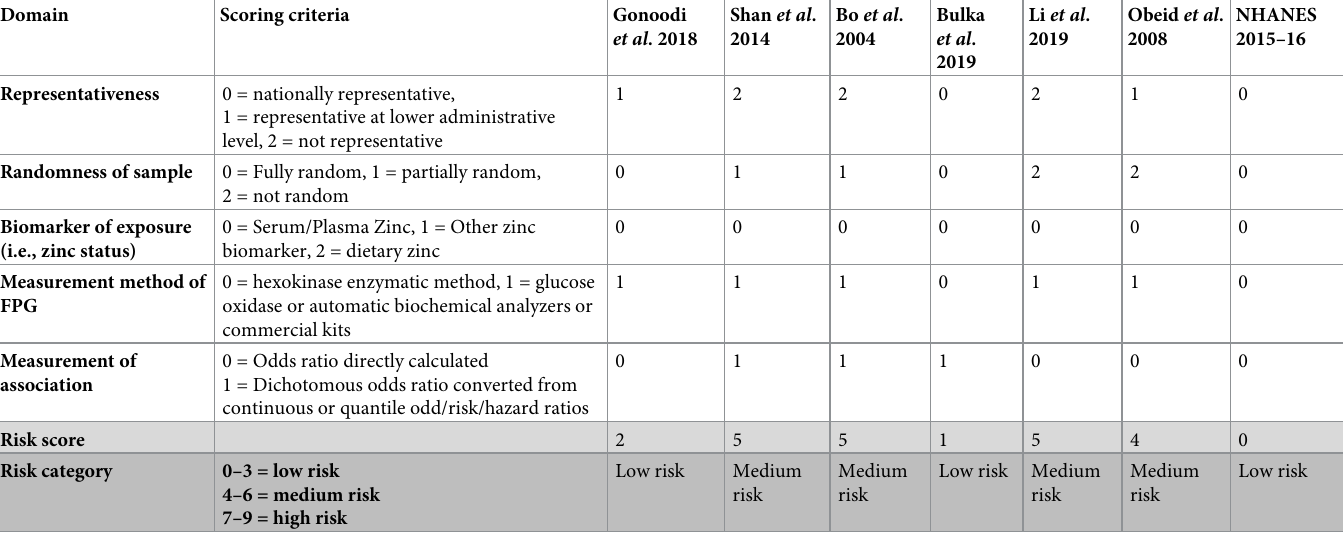
Table 2. Risk-of-bias assessment by study and domain. Bias rankings were based on a modified version of the Newcastle Ottawa Scale for evaluating the quality of non- randomized studies in meta-analyses [26].